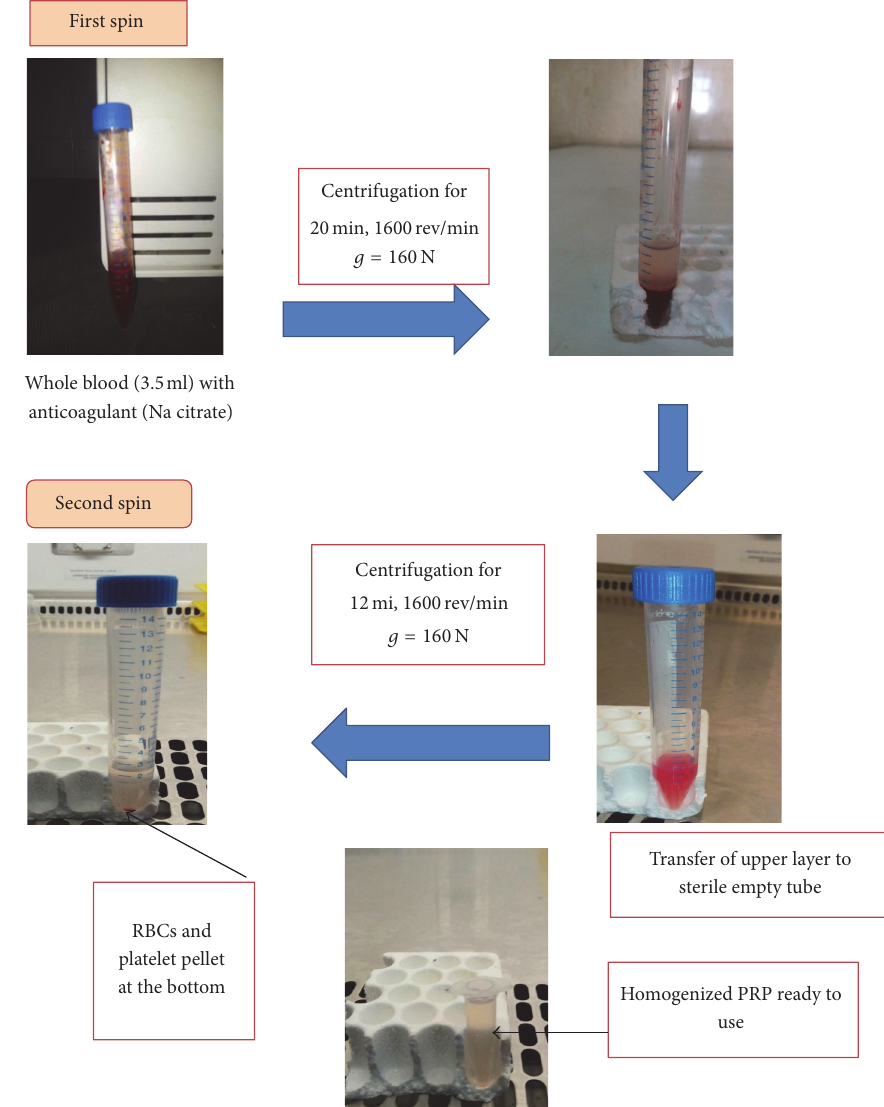
Figure 1: Flowchart describing preparation of